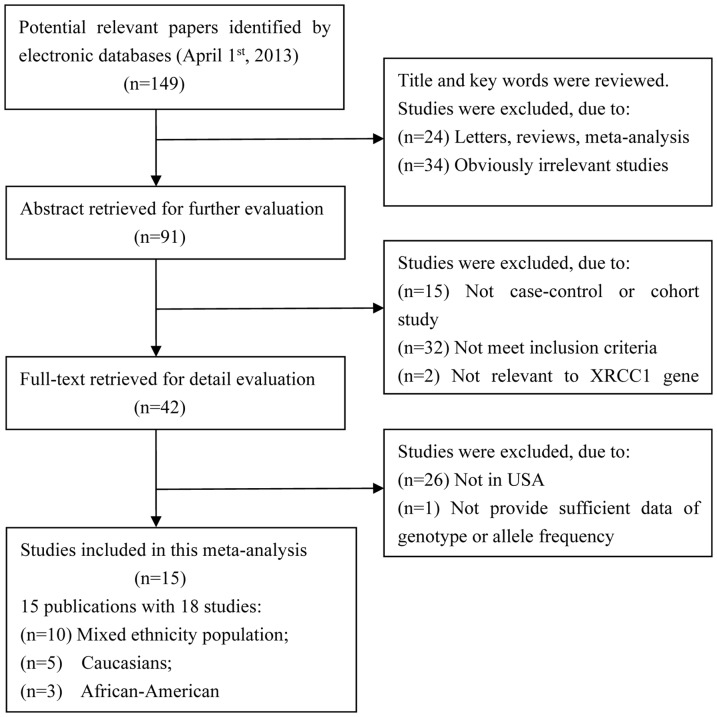
Flow chart of literature search and selection in the meta-analysis.